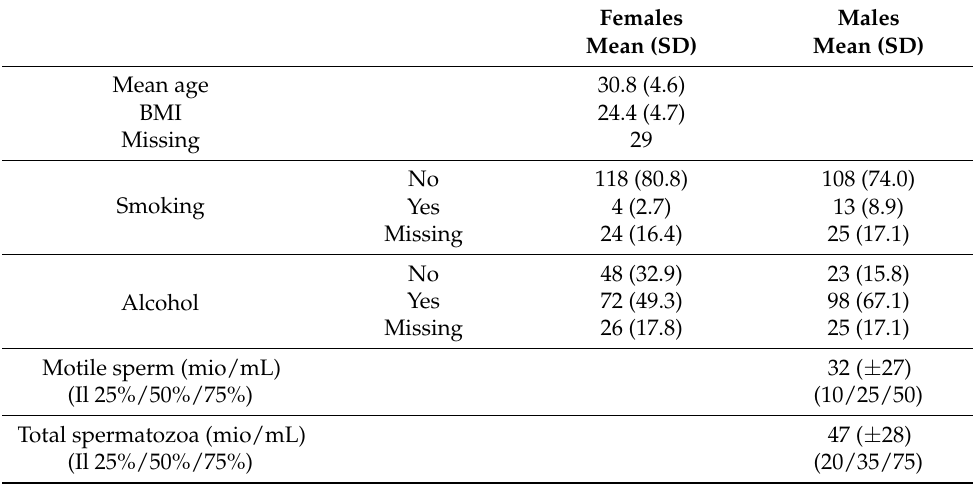
Table 2. Basic characteristics for couples with baseline semen evaluation.